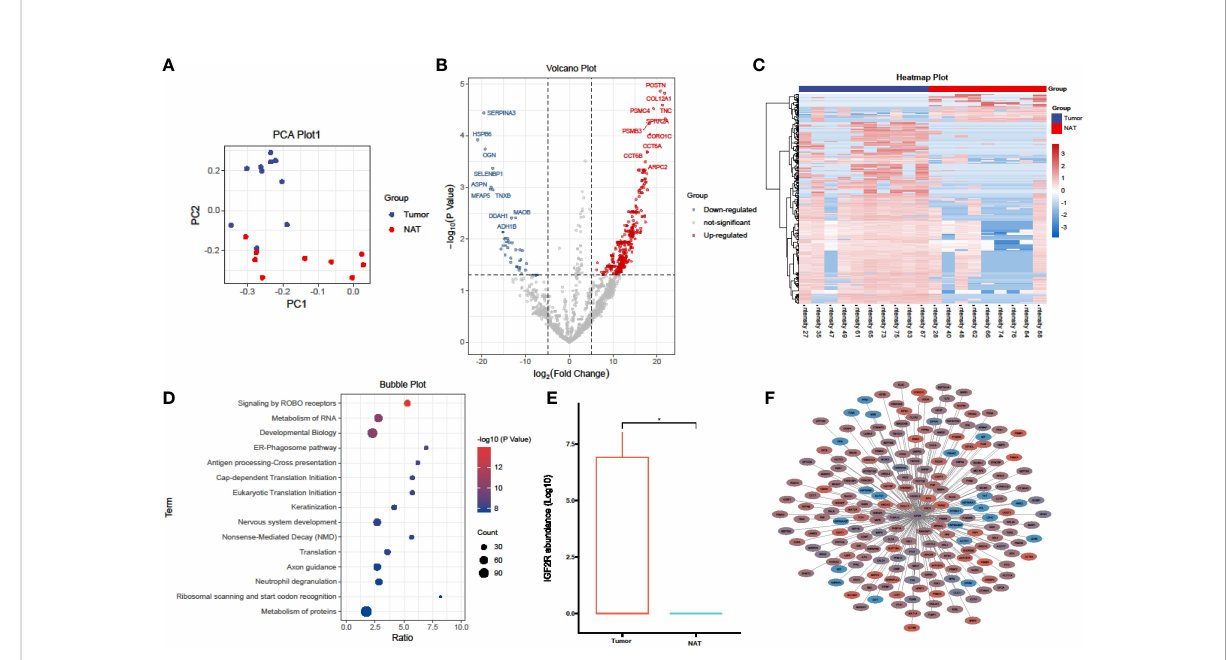
FIGURE 1 Proteomics analysis comparing laryngeal cancer to adjacent normal tissues. (A) PCA plots of the proteins identi fi ed in laryngeal cancer and adjacent normal tissues (laryngeal cancer tissue, n = 10; adjacent normal tissues, n = 9). (B) Volcano plot showing the DEPs in laryngeal cancer and adjacent normal tissues. (C) A heatmap illustrating the expression of DEPs in laryngeal cancer and adjacent normal tissues; each row represents one protein, and each column represents one sample. (D) A bubble plot depicting the enriched KEGG pathways of DEPs identi fi ed in laryngeal cancer and adjacent normal tissues. (E) A box plot of IGF2R protein expression in laryngeal cancer and adjacent normal tissues. *p < 0.05, student ’ s t test. (F) Network analysis of the correlation between DEPs and IGF2R (|R| > 0.5, P < 0.05), line thickness represents the strength of the correlation, blue represents downregulation, and red represents